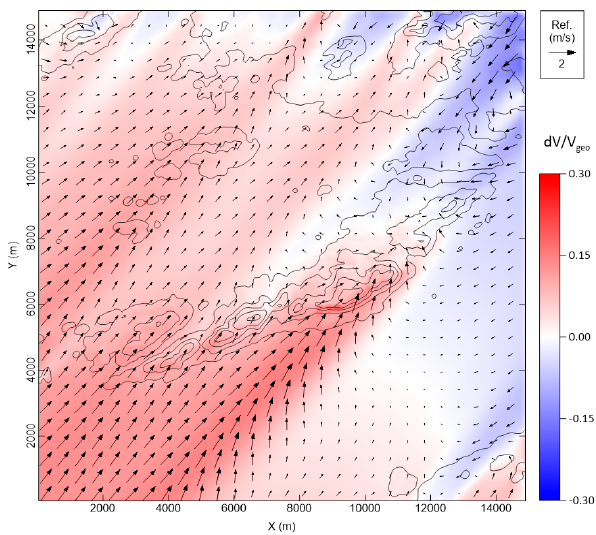
Figure 4. Error wind field of the mirrored initial condition for the north-easterly wind case (10 meters above ground level). Table 1. Comparison of approximation error of normalized wind speed difference and wind direction difference by the method of generating the initial condition.